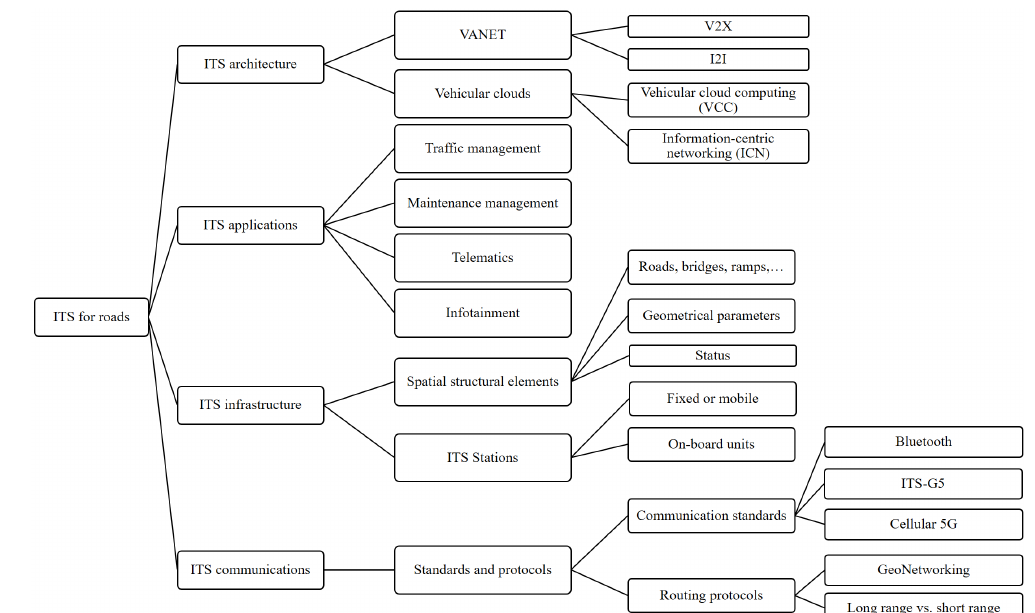
Figure 1. Taxonomy of the knowledge sources relevant to this